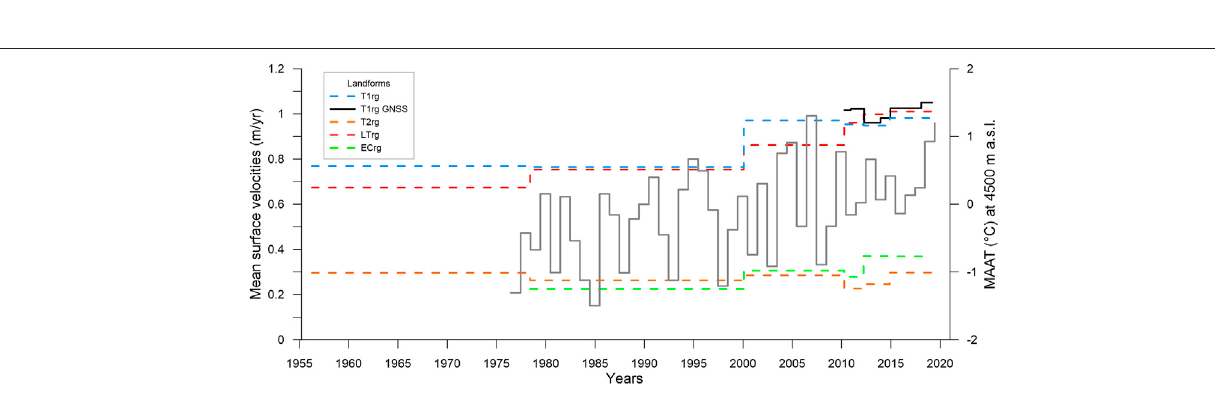
Frontiers in Remote Sensing |